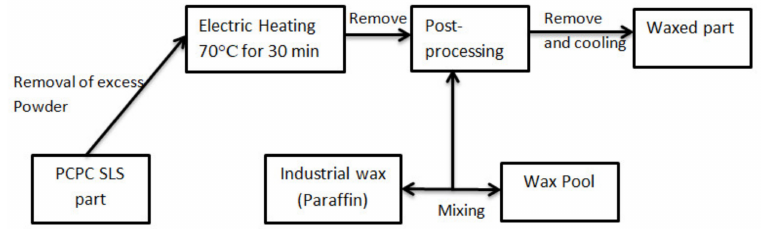
Figure 4. The post-processing flow chart of the PCPC parts.